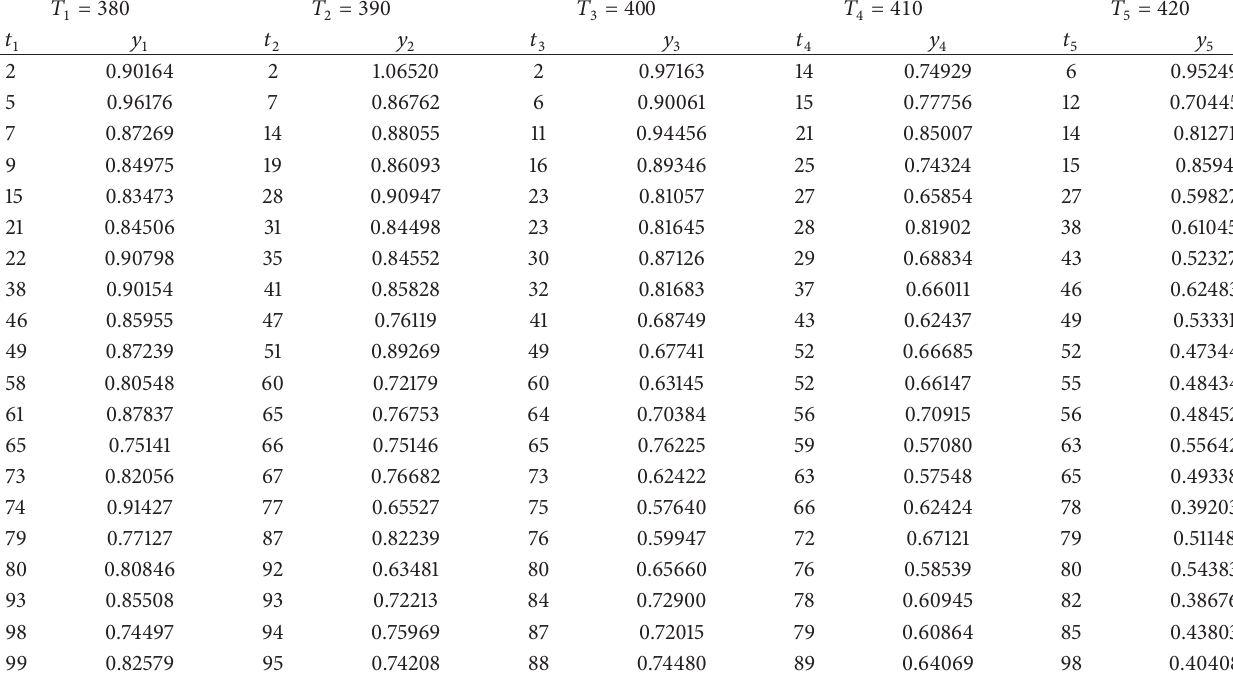
Table 1: Data for y - t - T by random